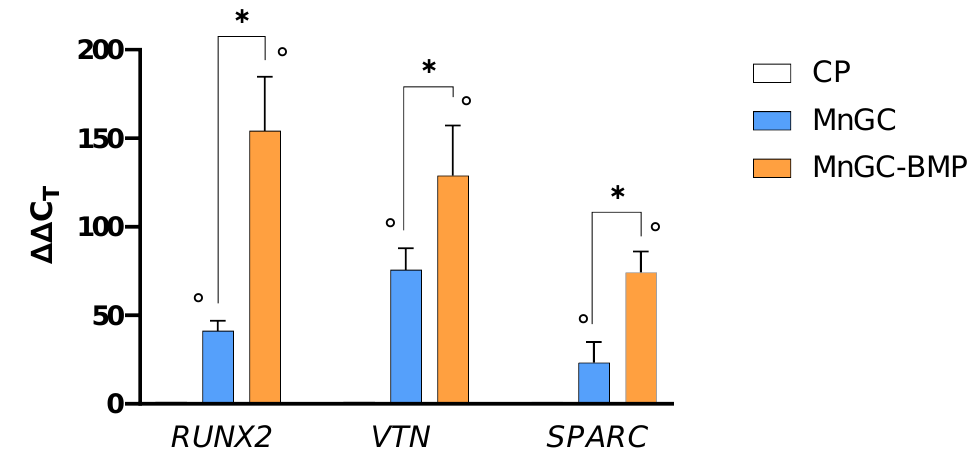
Figure 10. Specific mRNA transcript levels coding human Runt-related transcription factor 2 ( RUNX2 ), Vitronectin ( VNT ), and Osteonectin ( SPARC ) were evaluated by quantitative RT-PCR in RNA isolated from osteoblast cells cultured on plastic supports (CP), MnGC, or MnGC-BMP for 24 h. Data are reported as mean ± standard error of 3 independent experiments, each performed in duplicate, and were calculated using the ΔΔ C T method. ° indicates p < 0.05 vs. CP; * indicates p < 0.02.